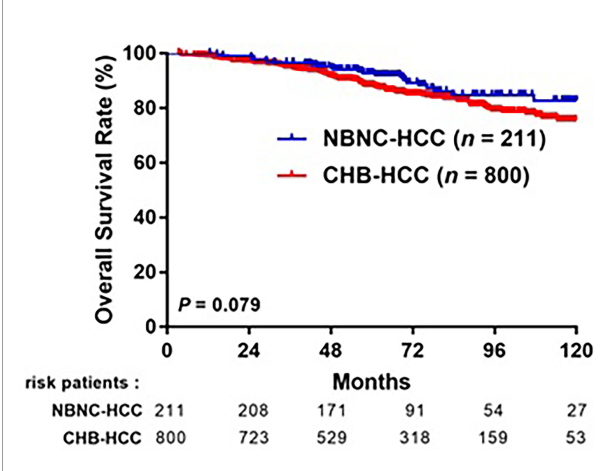
FIGURE 3 | Kaplan-Meier curves of overall recurrence-free survival (RFS) in patients with CHB-HCC or NBNC-HCC receiving curative resection.